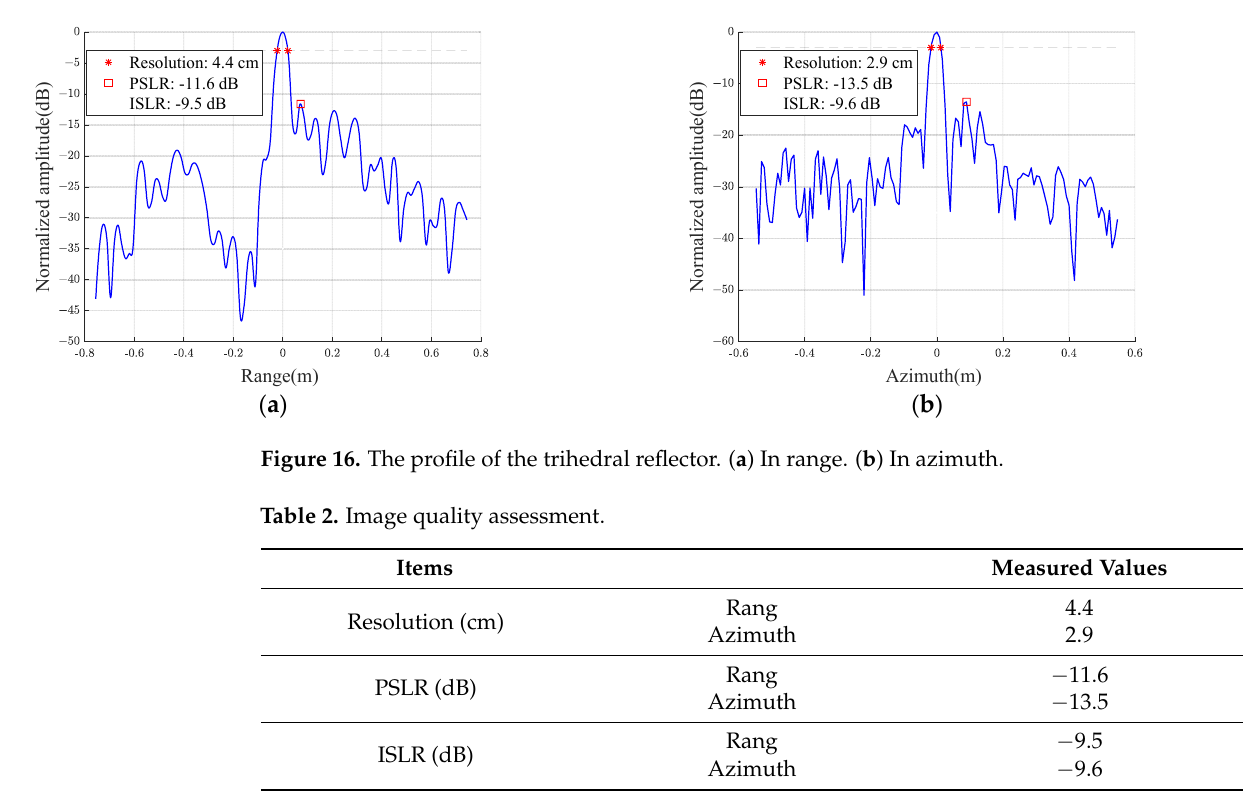
Table 3. Key technical specifications of typical UAV mini-SAR. Ref.